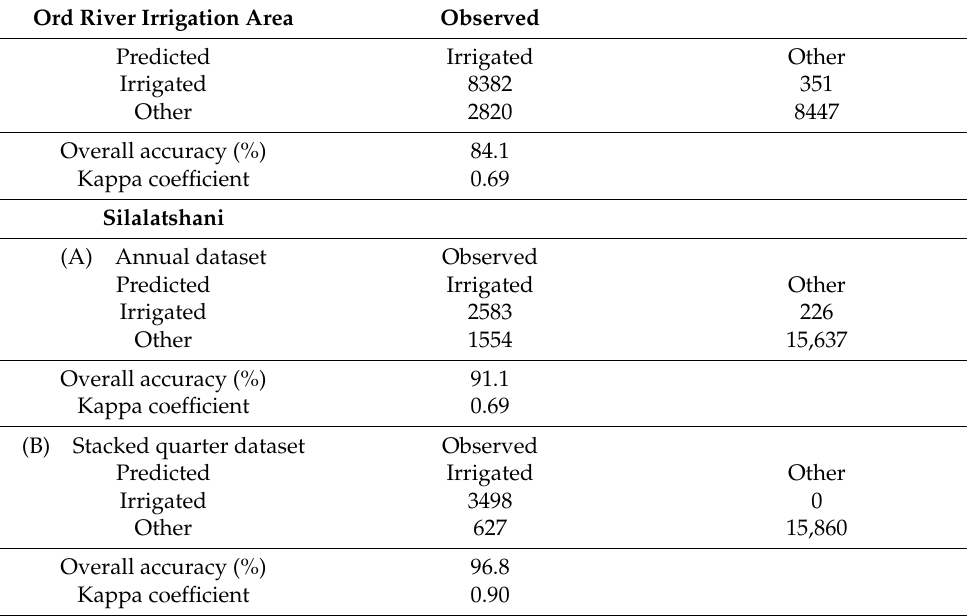
Table 4. Confusion matrices, overall accuracy, and Kappa coefficients for classification model performance on validation data (20,000 pixels) for all datasets